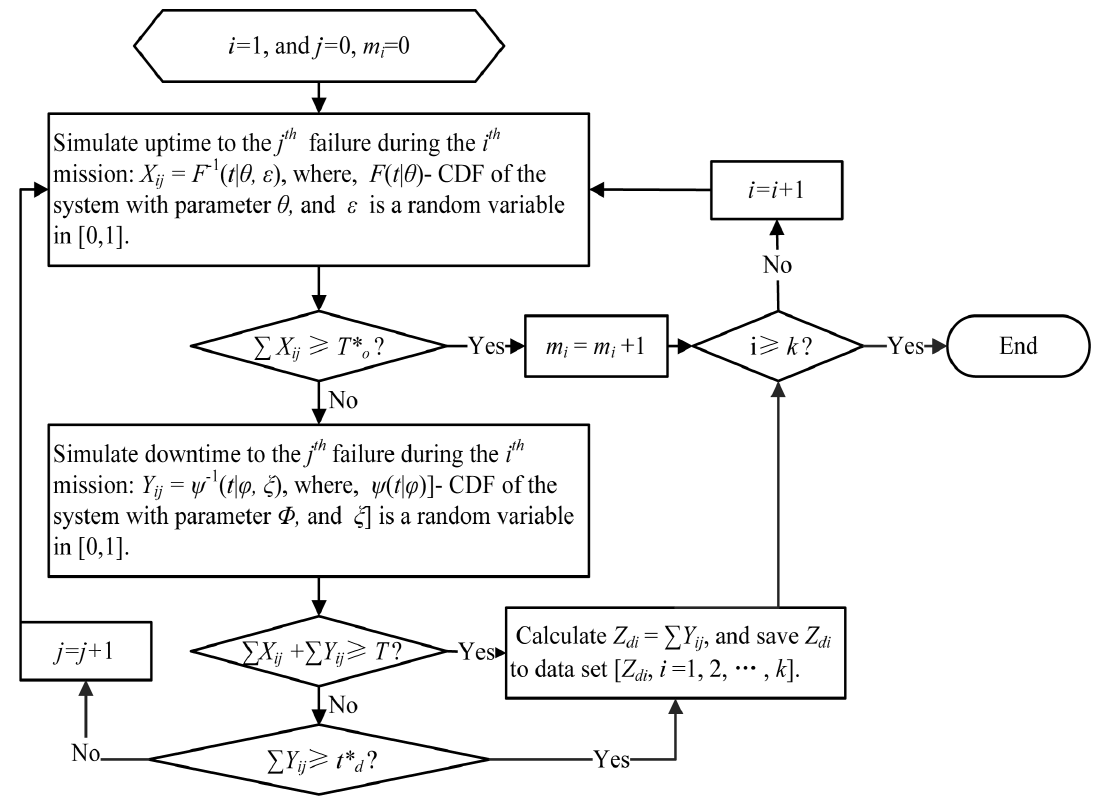
Figure 3. MC simulation procedure of mission independence.